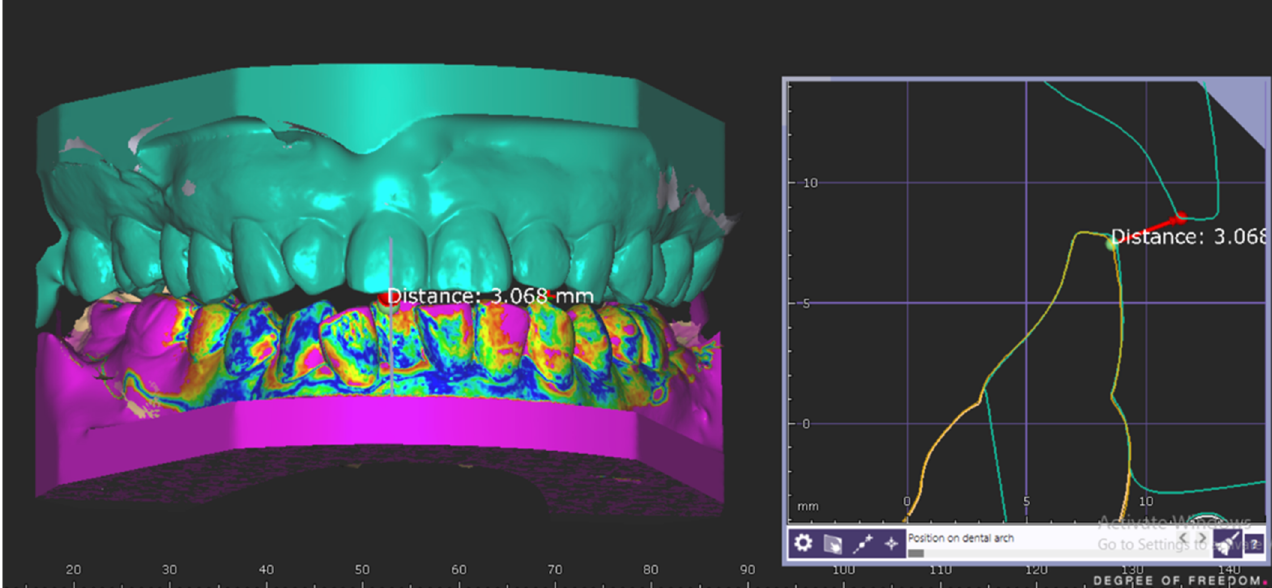
Figure 3. Anterior and posterior interocclusal measurements at OVD + 3 mm in the IOG.